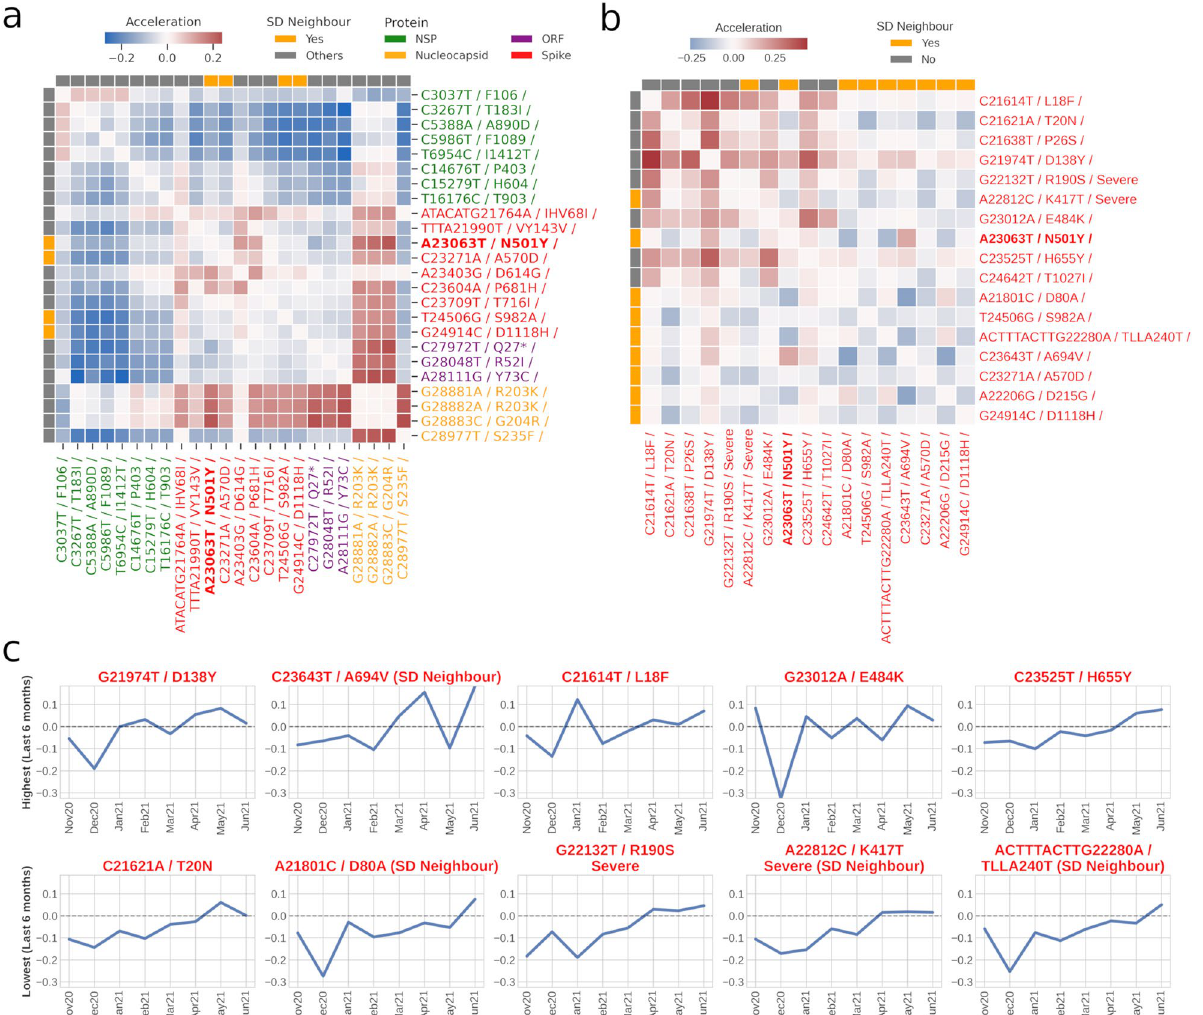
Figure 7. Semantic Acceleration of A23063T with associated mutations. ( a) Heatmap of semantic accelerations between Jan2021 and Jun2021 among mutations identified from signature3 of the dynamic topic model. This signature consisted of mutation of concern A23063T. ’SD neighbour’ refers to mutations that were most recurrent as neighbouring mutations of A23063T from Oct2020 to Jun2021. ( b) Heatmap of semantic accelerations between Jan2021 and Jun2021 among key mutations of Lineage P.1 15 and nine SD neighbours of A23063T. ( c) Dynamic acceleration tracking of ten mutations from panel ( b ) against A23063T. The top row highlights five mutations with the highest sum of accelerations between Jan2021 to Jun2021. The bottom row highlights five mutations with the lowest sum of acceleration between Jan2021 to